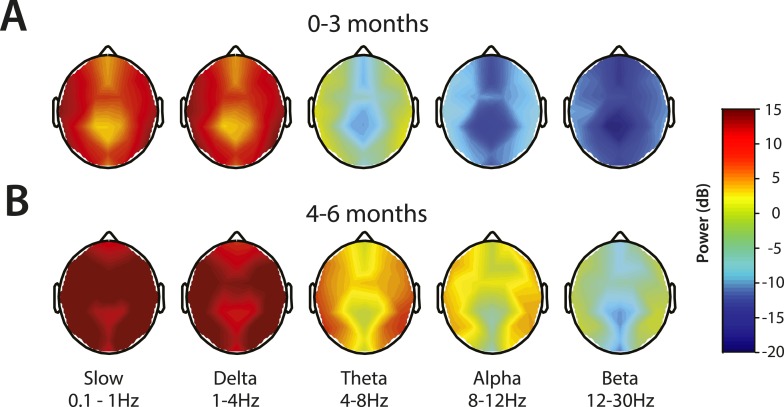
Topographic EEG maps of spectral power for distinct frequency bands during MOSSA.Topographic EEG maps detailing group-averaged power for each EEG frequency band in infants aged (A) 0–3 months (n = 11) and (B) 4–6 months (n = 19). Slow-wave activity is distributed across the scalp in both postnatal age groups, while alpha activity is present to a greater degree in infants 4–6 months postnatal age. Legend for A and B is shown by the color bar.